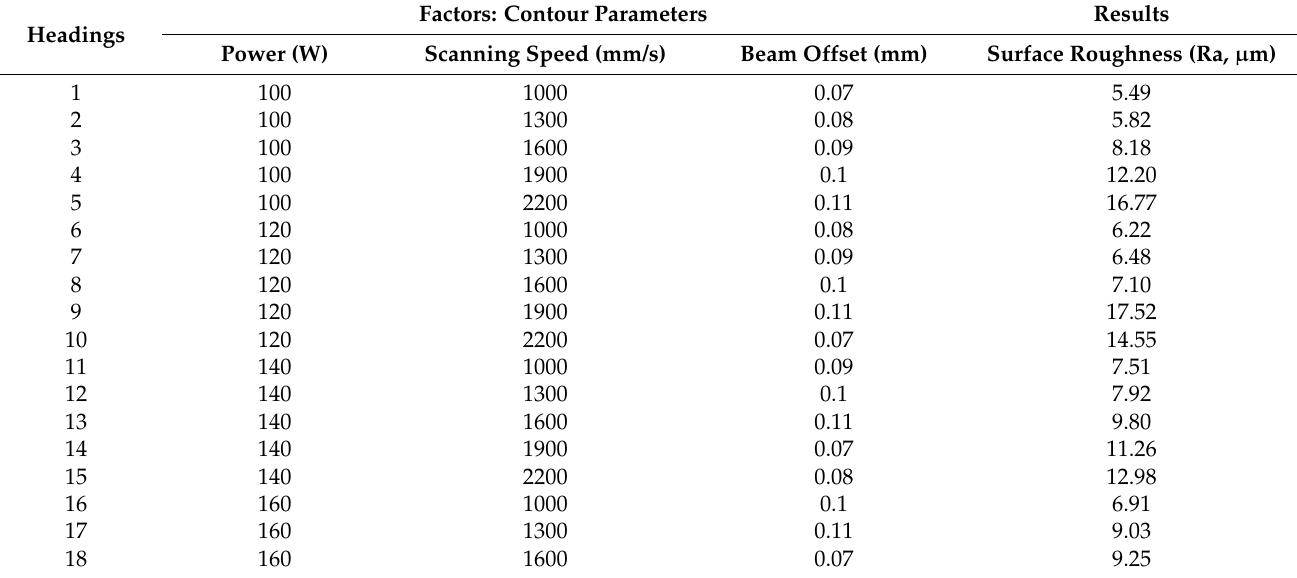
Table 7. L 25 (5 3 ) orthogonal test and experimental results of surface roughness with contour scans